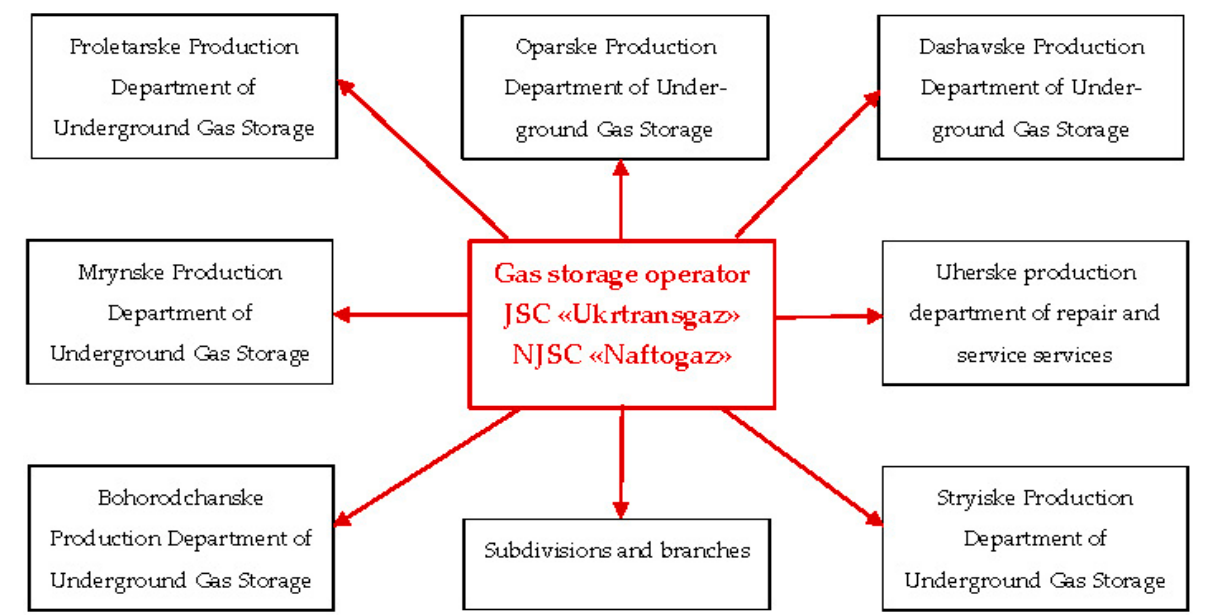
Figure 2. Structure of the Gas storage operator JSC “Ukrtransgaz” as of 1 January 2022. Source: [32].